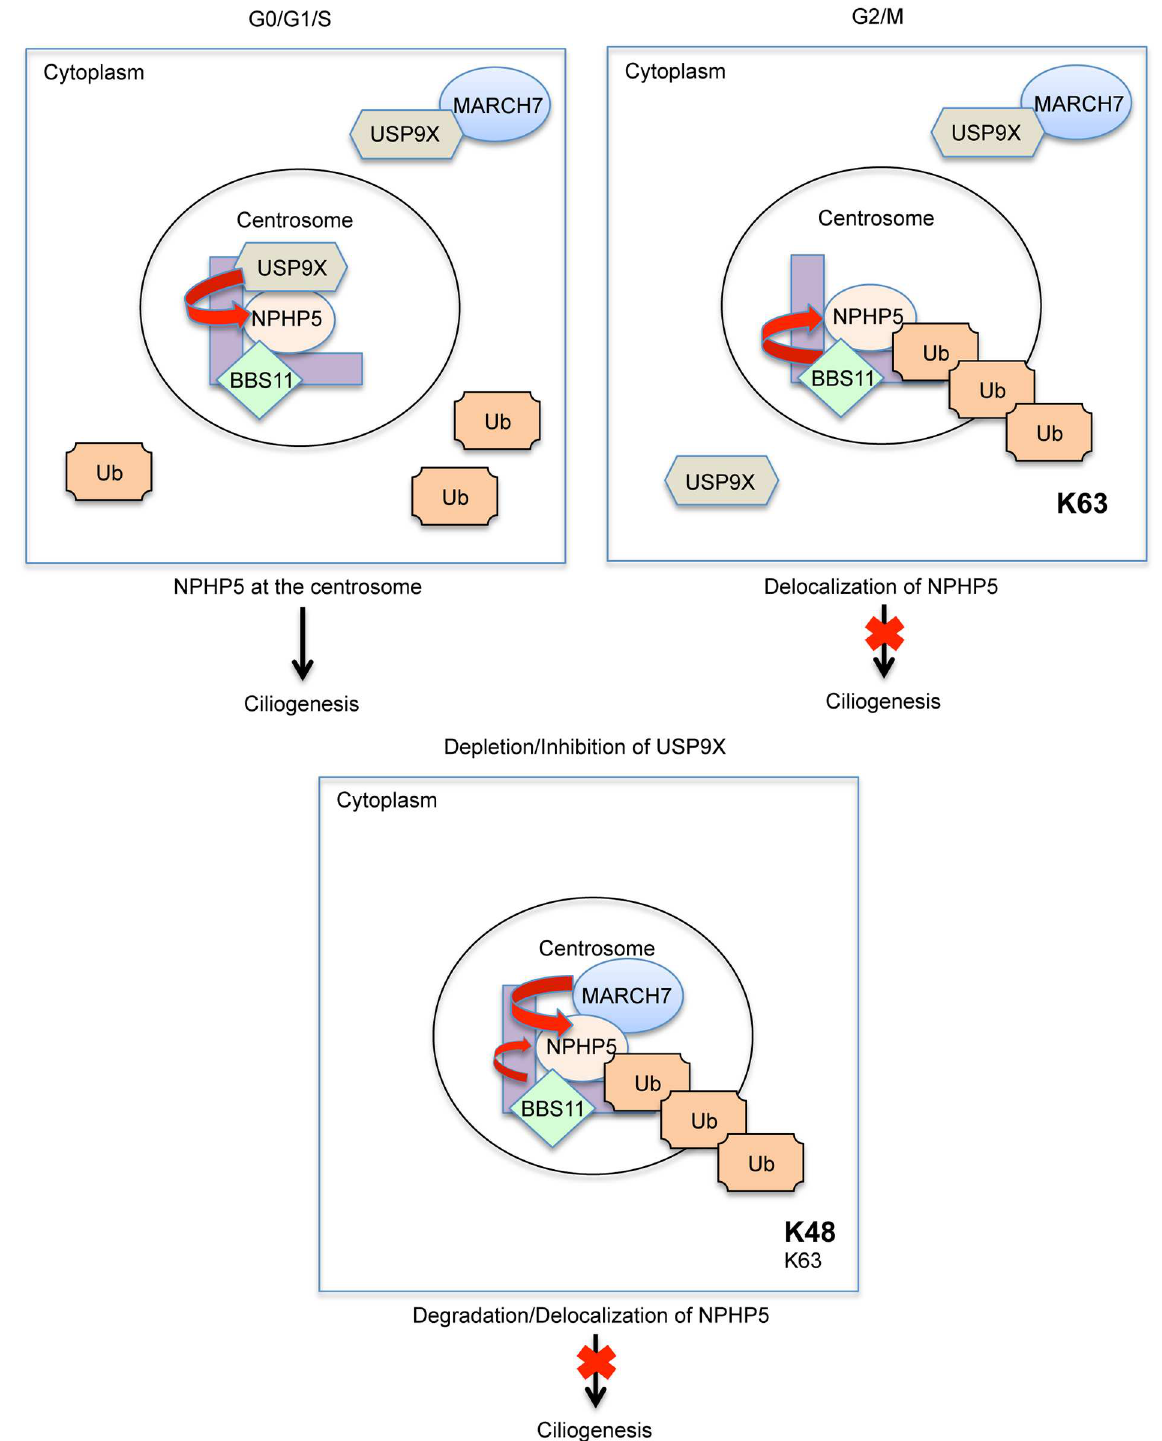
Fig 9. Model depicting the role of ubiquitination and deubiquitination in controlling NPHP5-mediated ciliogenesis. (Top left) In the G0/G1/S phase, a pool of cytoplasmic USP9X is recruited to the centrosomeby NPHP5. MARCH7 is held in the cytoplasm by USP9X, whereasBBS11 is localizedto the centrosome. Becausecentrosomal USP9X actively deubiquitinates NPHP5, NPHP5 is stabilizedand cilia assembly is favoured. (Top right) In the G2/M phase, USP9X dissociationfrom the centrosomemakes NPHP5 prone to ubiquitination. NPHP5 undergoesK63-ubiquitination by BBS11 and becomes delocalized, and cilia disassemblyis favoured.